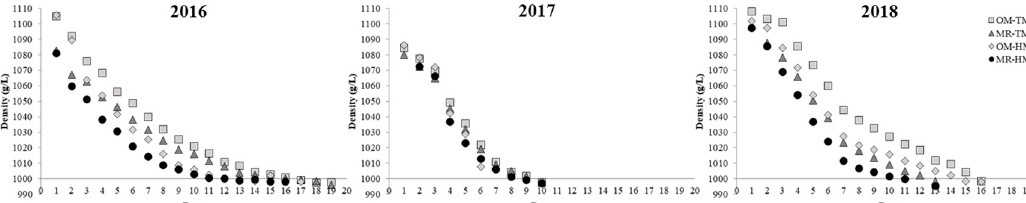
Figure2. Fermentationkineticsofthetreatmentsbytheyearofvintage. Averageofthreewines. OM-TM: Figure 2. Fermentation kinetics of the treatments by the year of vintage. Average of three wines. OM- TM: original must and traditional maceration; MR-TM: must replacement and traditional maceration;